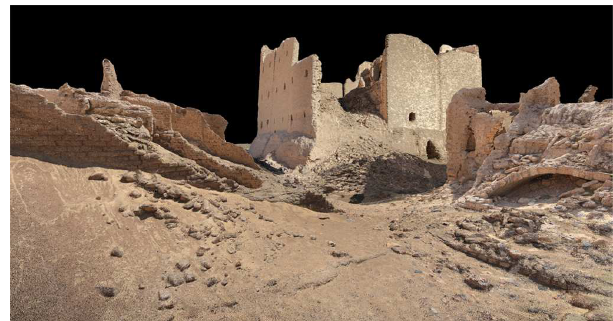
Figure 6. An interesting “Point Cloud view” of the central castle from the actual